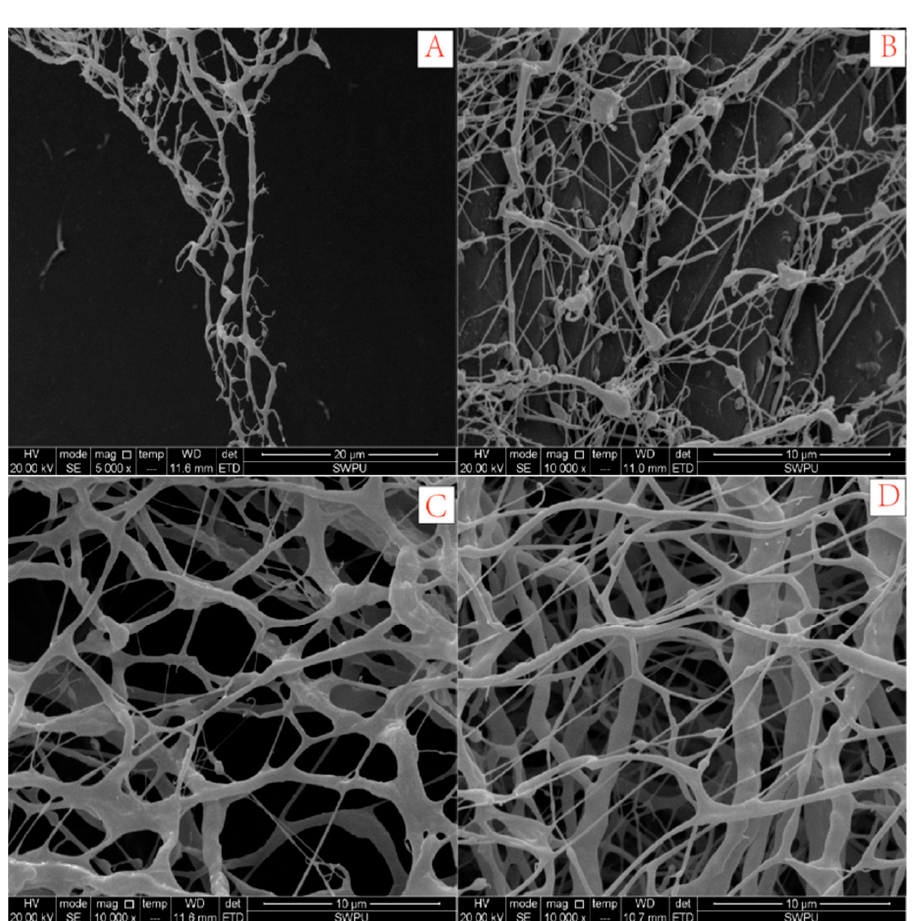
Figure 6. The representative SEM images of the DiPHAM aqueous solution association process. ( A ) 100 mg/L (×5000); ( B ) 300 mg/L (×10,000); ( C ) 500 mg/L (×10,000); ( D ) 700 mg/L (×10,000).